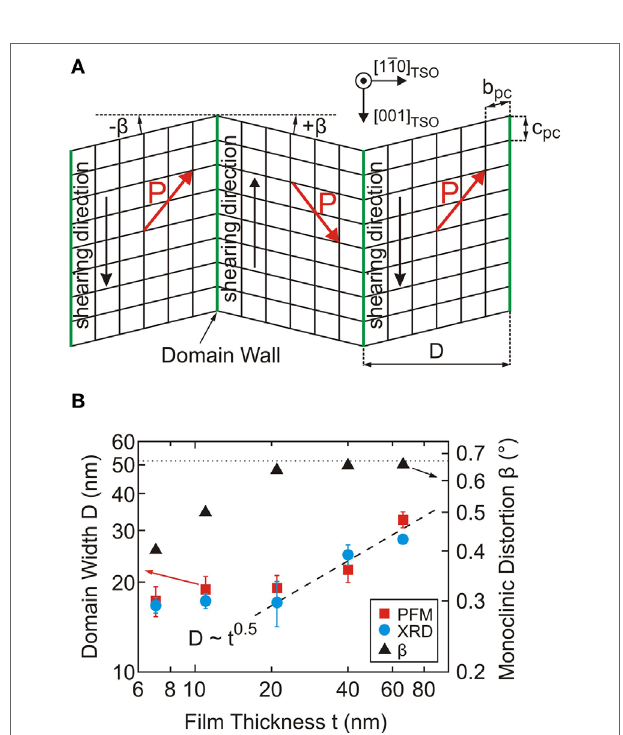
FigUre 6 | (a) Schematic presentation of the monoclinic shearing of the pseudocubic unit cells and resulting polarization vector (red arrows). Adjacent domains are sheared in opposite directions (black arrows). The monoclinic angles ± β are exaggeratedly illustrated. (b) Domain width D (red squares and blue circles deviated from PFM and X-ray measurements, respectively, left axis) and monoclinic angle β (black triangles, right axis) versus film thickness for NaNbO 3 films grown on TbScO 3 substrates.